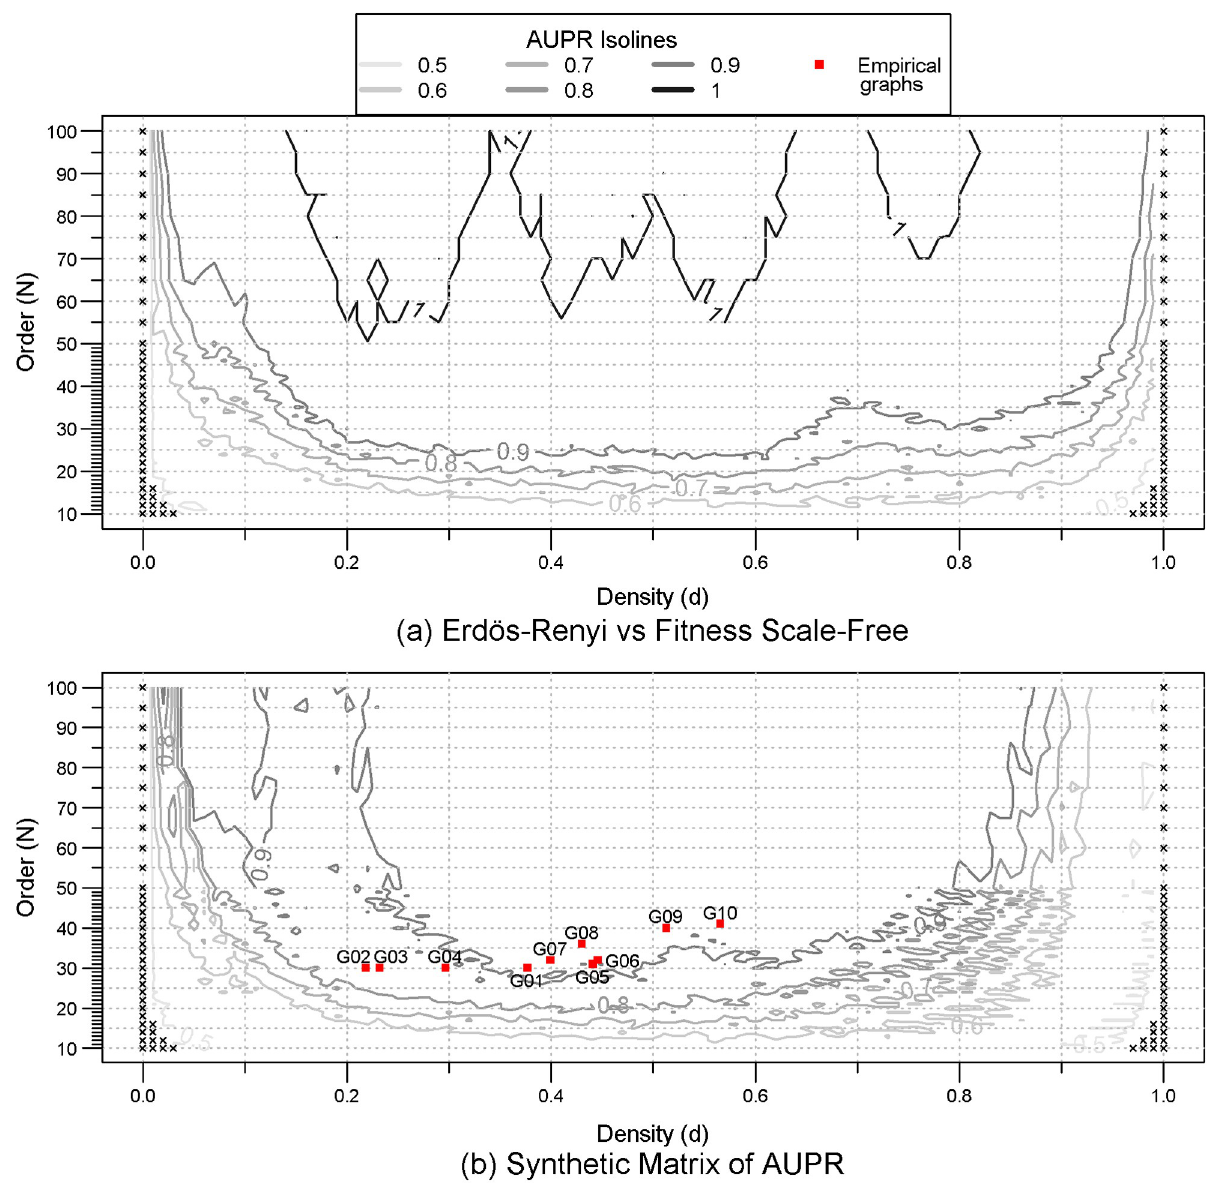
Fig 1. Quality of the discrimination between models (AUPR). (a) Diagram of the matrix of AUPR Erd ő s-Re´nyi vs Fitness Scale-Free ( A Diagram of the synthetic matrix of AUPR ( A ( N , d )). For each pair of models, and for each order (from 10 to 100) and edge density (from 0 to 1) combination, the quality of clustering between 100 graphs of each of the two types of models is assessed by the Area Under the Precision-Recall curve (AUPR). A maximum value of 1 corresponds to perfect discrimination. Black crosses represent zero AUPR. Empirical graphs (red squares) are projected according to their features (order and edge